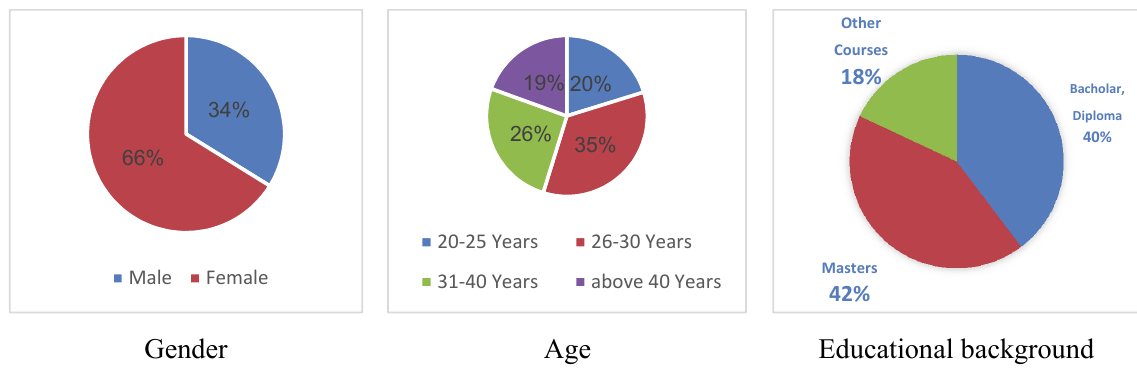
Fig. 3 indicates the output for the demographic characteristics of the respondents.